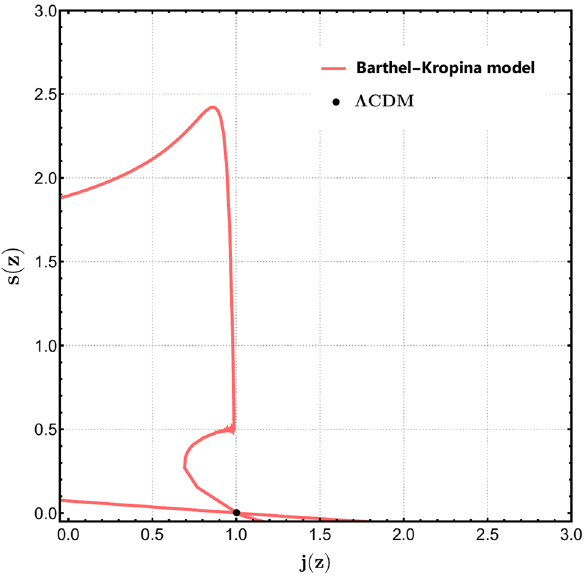
Fig. 8 The evolution of the snap parameter s as a function of the jerk parameter j in the Barthel–Kropina and (cid:2) CDM models